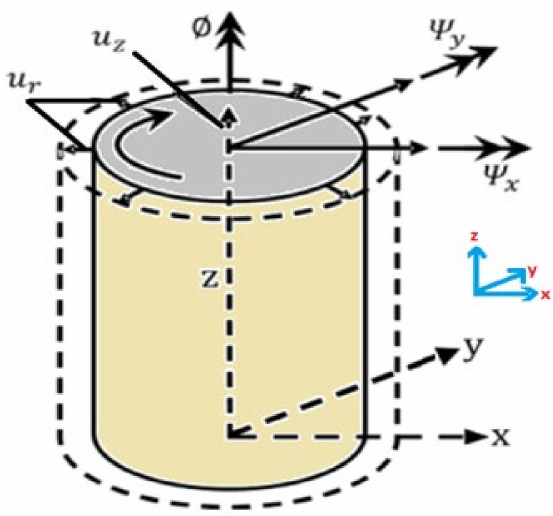
Figure 4. Sign conventions for the cylindrical layer of tubular pipe showing force and deformations.